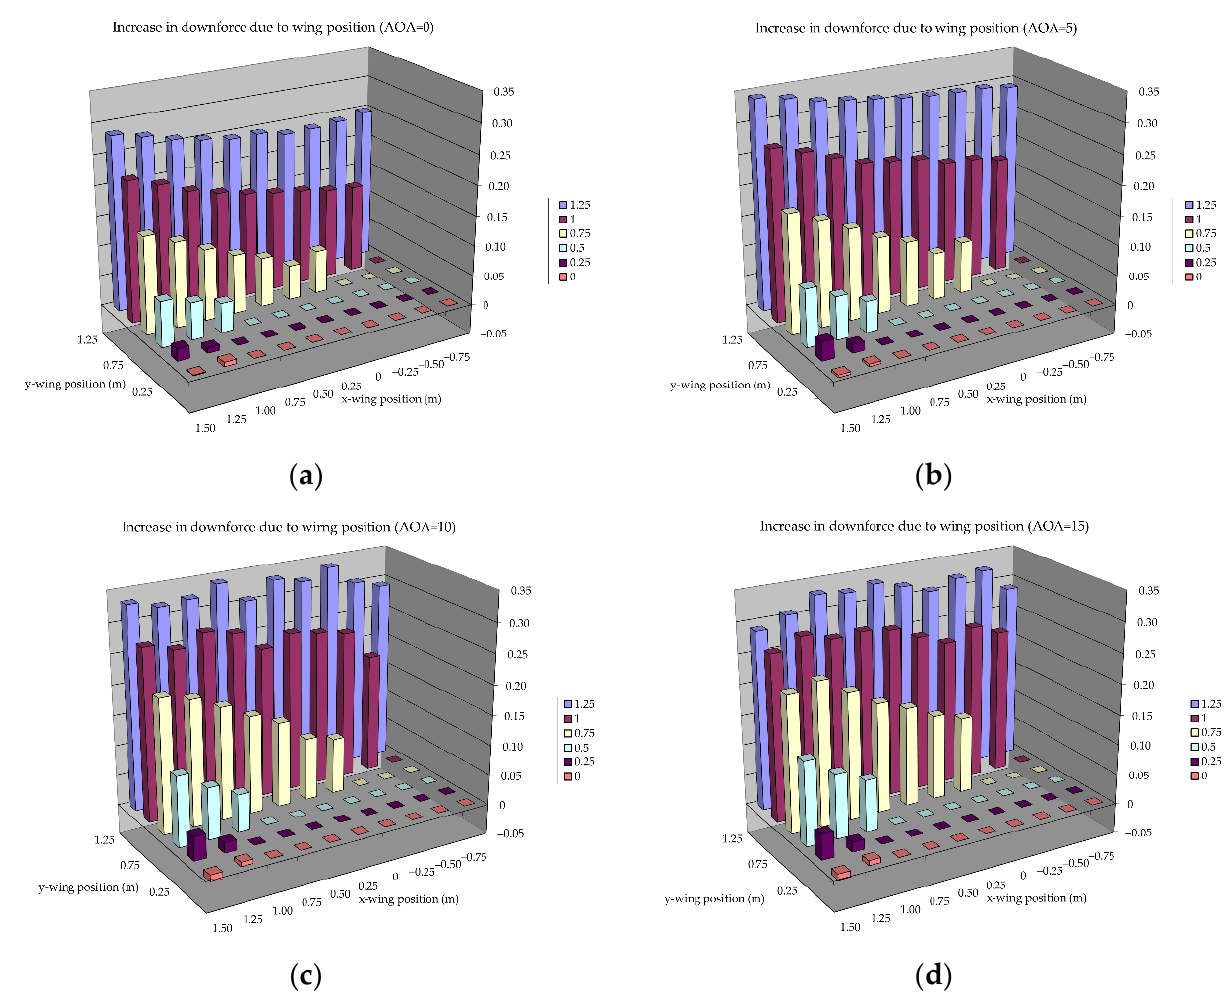
Figure 19. Increases in aerodynamic downforce coefficient as a function of the angle of attack and wing position in relation to the car body: ( a ) AOA 0 degrees; ( b ) AOA 5 degrees; ( c ) AOA 10 degrees; ( d ) AOA 15 degrees.